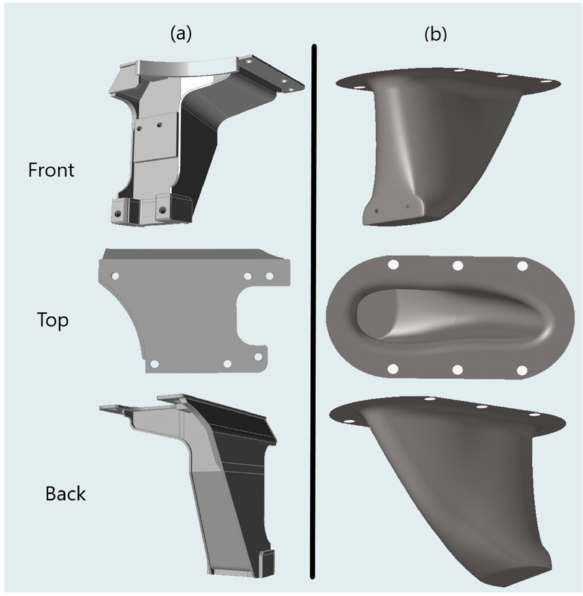
Figure 3. Typical steel anchor bracket ( a ), and composite anchor bracket ( b ) designed to replace the steel